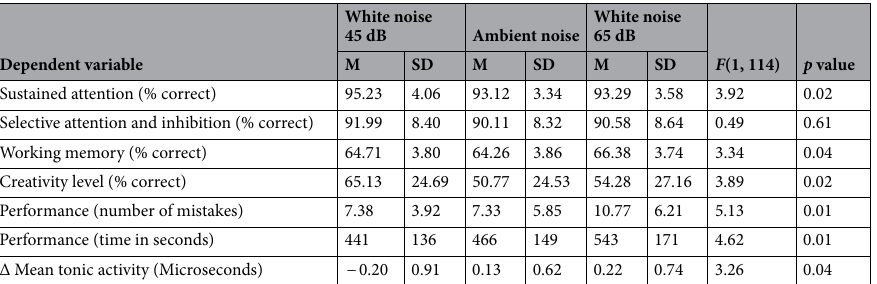
Table 1. Means, standard deviations, and one-way analyses of variance of the study measures under different noise